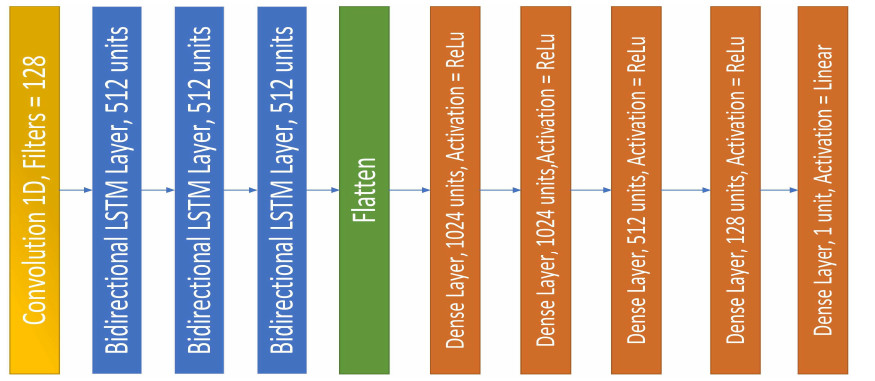
Figure 7. Architecture of the CNN bi-directional-LSTM model.